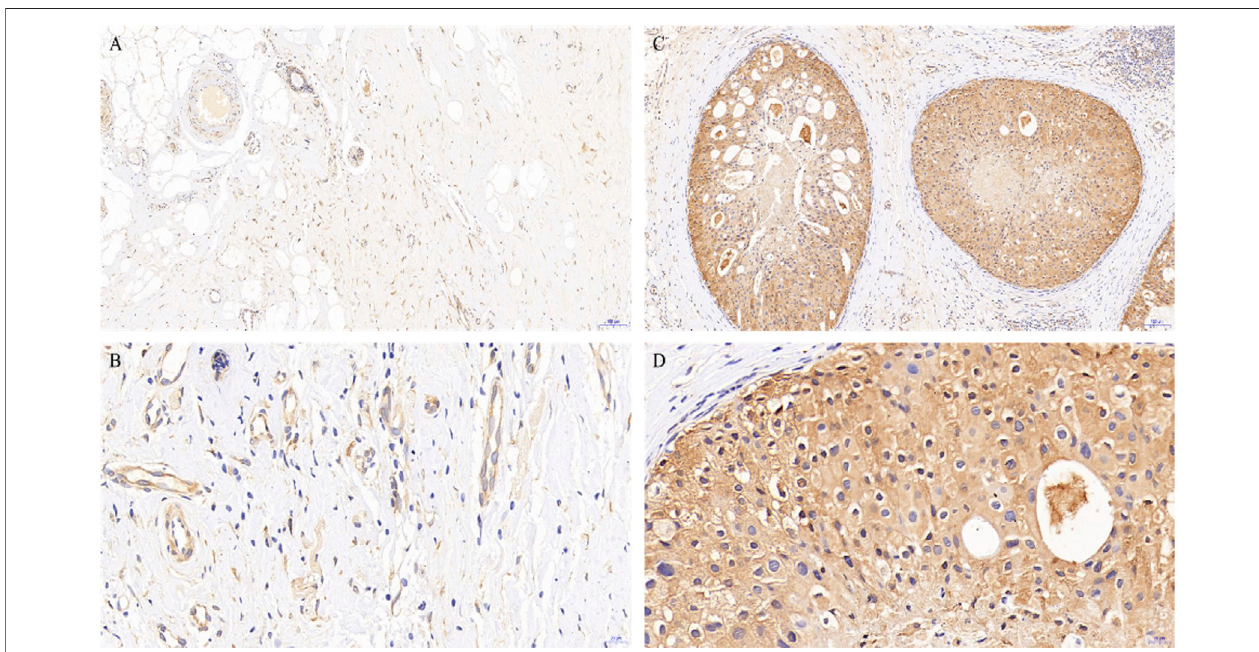
FIGURE 2 | PGRMC1 expression in TNBC and paired normal breast tissues. Negative expression of PGRMC1 in normal breast tissues determined by immunohistochemistry(magni fi cations: A:10 × ,B:40 × ).Positive expressionofPGRMC1 inbreastcancertissuesdeterminedbyimmunohistochemistry(magni fi cations: C: 10 × , D: 40 × ). Signals for PGRMC1 have brown color; nuclei are blue. Dashed arrows represent the negative staining for